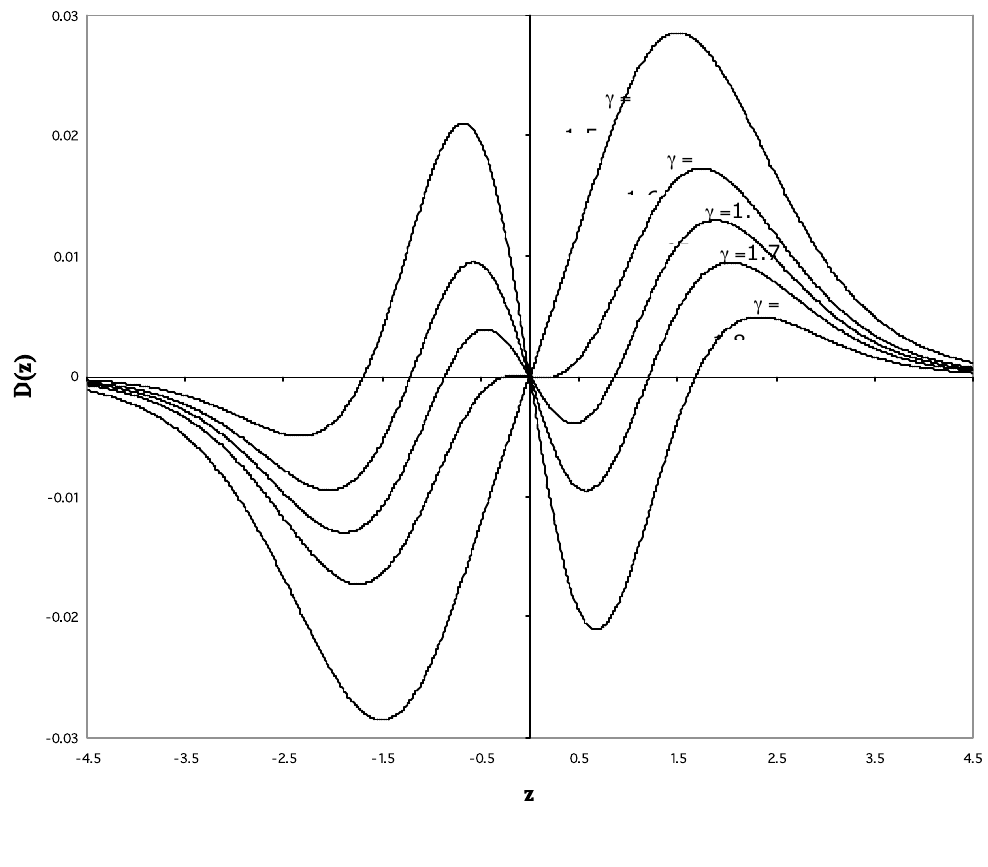
Figure 2. “The variation of the deviation function for different values of γ